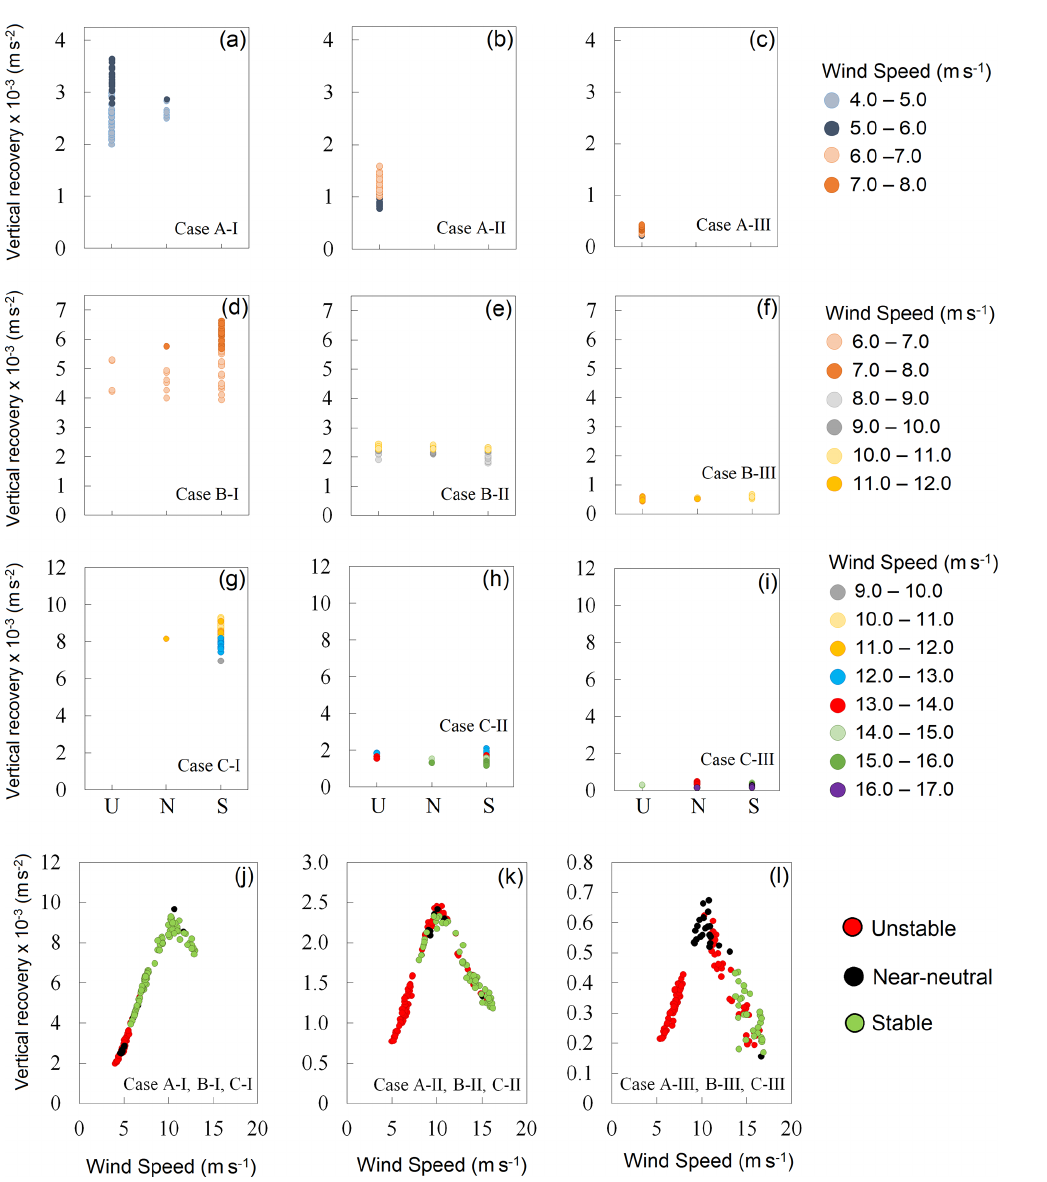
Figure 10. Same as Fig. 9, but the stability classification is done using a non-local lapse rate